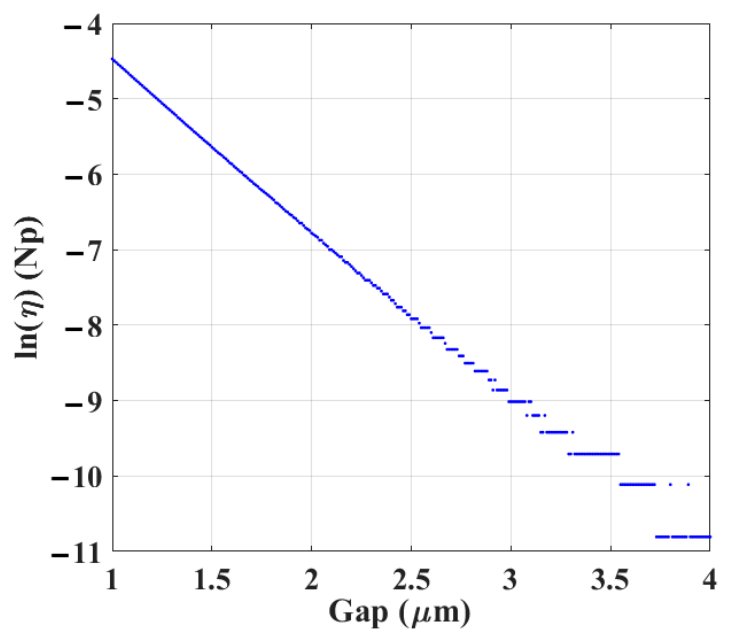
Figure 5. Natural logarithm of the integrand η ( µ m − 1 ) from (21) vs. gap. A good fit to the measured data, especially at the peak and notch of the drop path and through path transmission, is necessary to disentangle loss and coupling coefficients. Good fits have been achieved at the resonant peaks and notches for all rings, although departure at high extinction can be observed due to the noise floor of the measurement. Figure 6 shows the fitted spectra of drop- and through-path transmission alongside the measured data for RR 1 , RR 2 , and RR 3 .